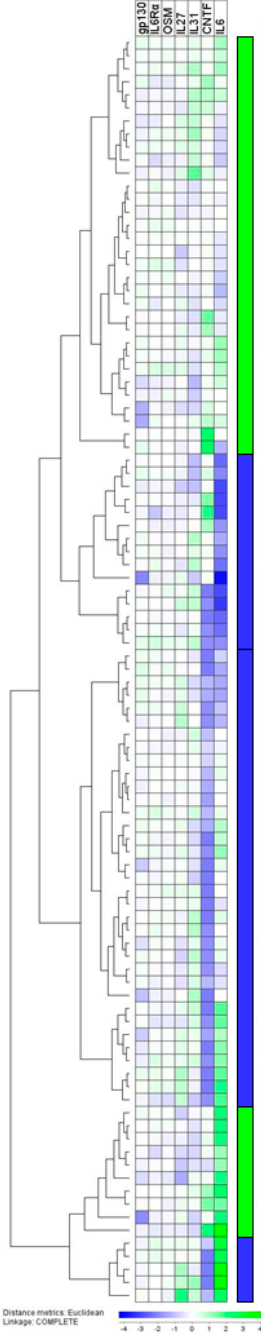
Figure 2. (see page 7). The serum profile of IL6 family cytokines in patients with renal cancer: a hierarchical cluster analysis. This analysis included the seven soluble mediators, IL6, IL6R α , gp130, IL27, IL31, CNTF, and OSM. Cytokine / receptor is indicated at the top of the figure, and the patient clustering is shown to the left. This analysis created two main clusters (an upper large and a small lower cluster), and each of these two main clusters were further divided into one subset with low IL6 / CNTF levels and one with relatively high levels of the two cytokines. Based on these results, we classified the patients into two main subsets referred to as CNTF high IL6 high (see the right part, indicated by a green color) and CNTF low IL6 low (right part, blue